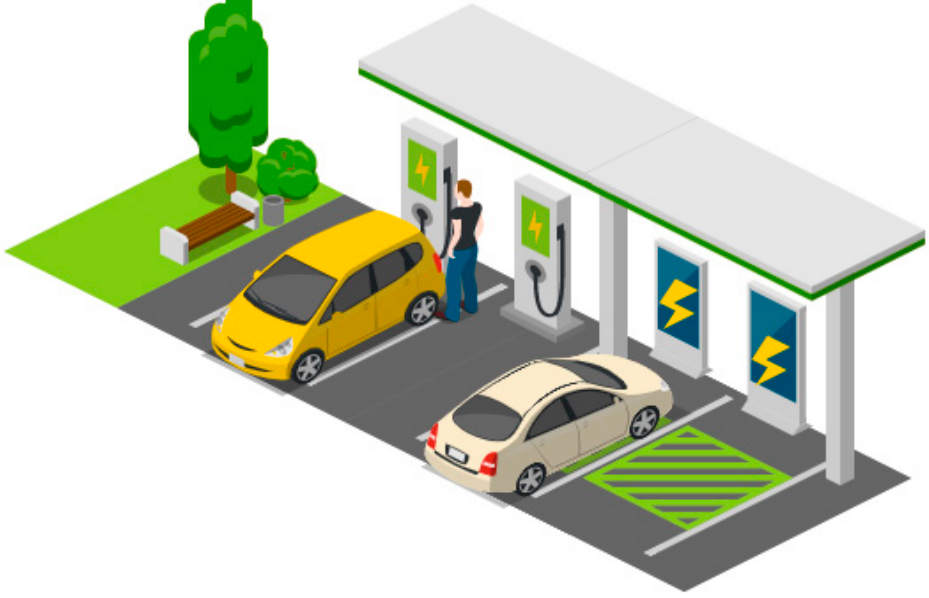
Figure 8. Wired charging ( left ) and static wireless charging ( right ) of EVs.